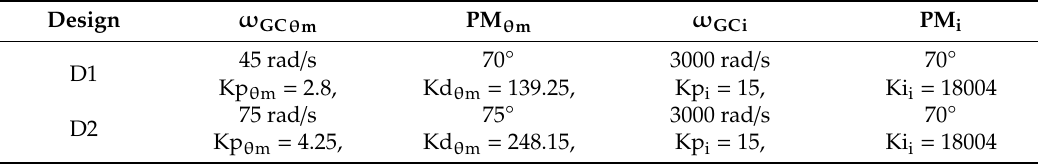
Table 2. D1 and D2 position controller designs for the PMSM